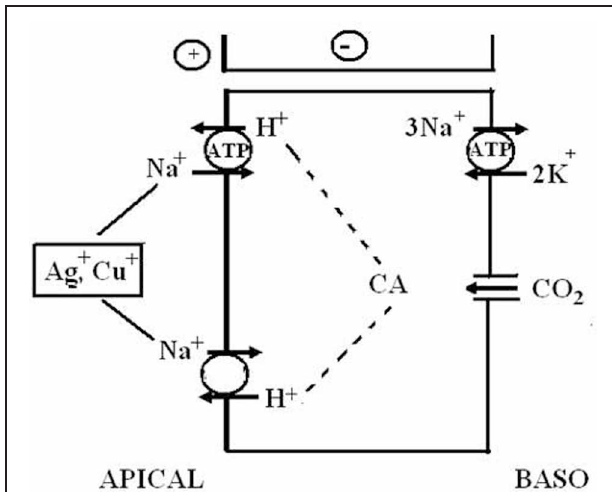
FIGURE 11 | Model of hypothetical transcellular pathway of the toxic metals Ag + and Cu + (after reduction of Cu 2 + by cell surface enzymes reductase) across gill epithelium of strong hyperosmoregulating Crustacea (freshwater and brackish water Crustacea). Toxic metals compete for putative Na-channel generated by V-type-H-ATPase, and/or electroneutral Na + /H + exchanger or Ca 2 + /2H + as proposed by lobster hepatopancrease brush border membrane vesicles. Toxic metals inhibits basolaterally located Na + , K + -ATPase, and carbonic anhydrase (CA). Later supplying counter ions H + and HCO 3 for ionic exchange by secondary generated transport